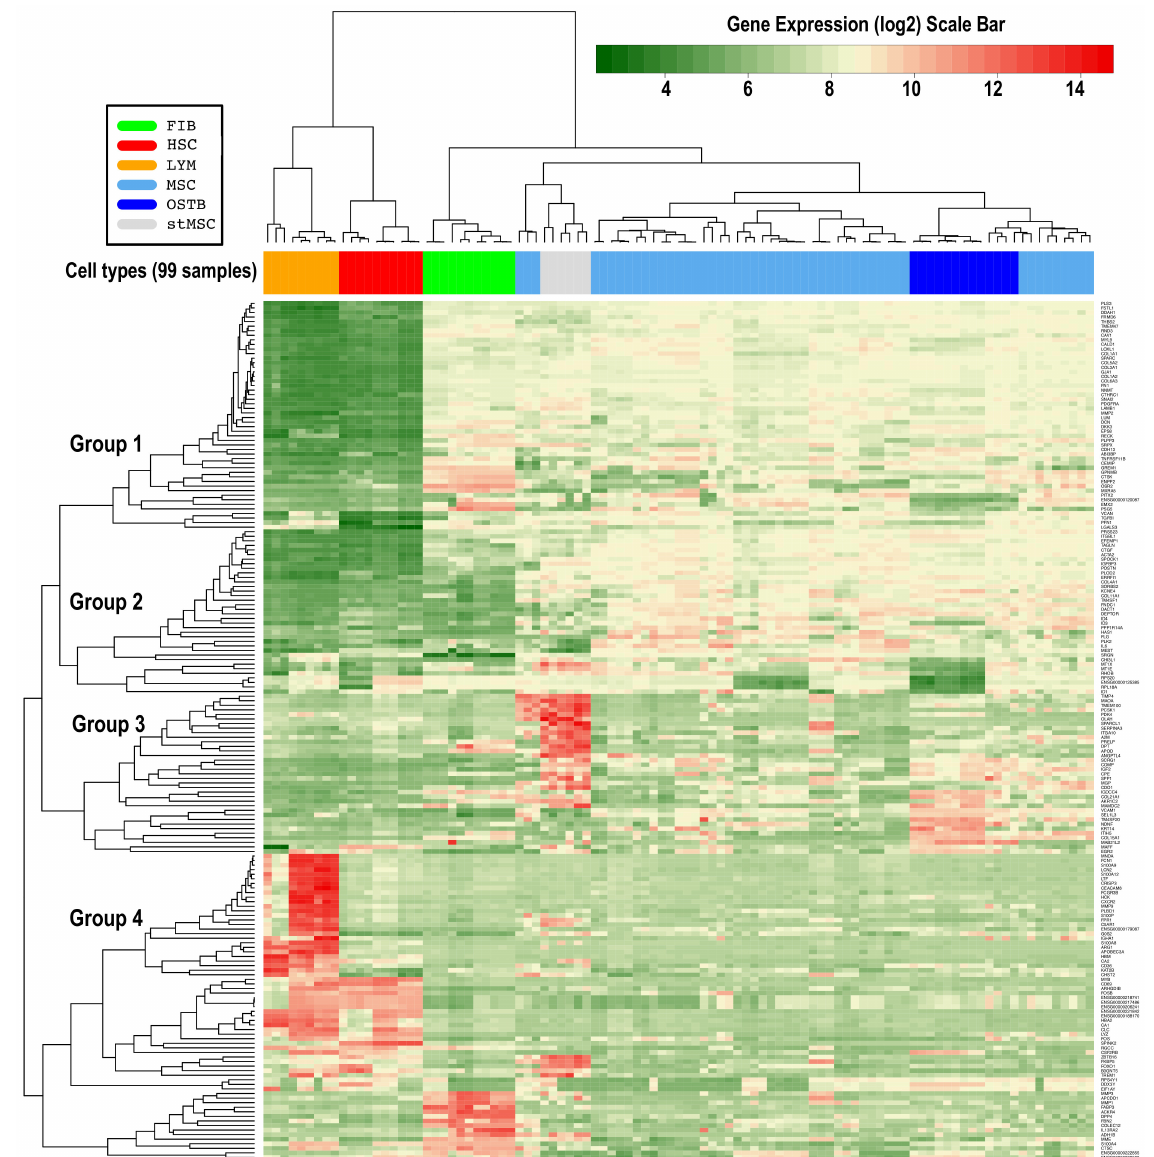
Figure 1. Heatmap presenting the expression profile of 188 genes found di ff erentially expressed in the pair-wise comparisons of the six main cell types studied: Mesenchymal Stromal Cells (MSC), hematopoietic stem cells (HSC), fibroblasts (FIB), lymphocytes (LYM), osteoblasts (OSTB), and MSCs stimulatedwithcytokines(stMSC).Thetop30geneswithmostsignificantchangesfromeachcomparison were taken, and the union of these gave the list of 188